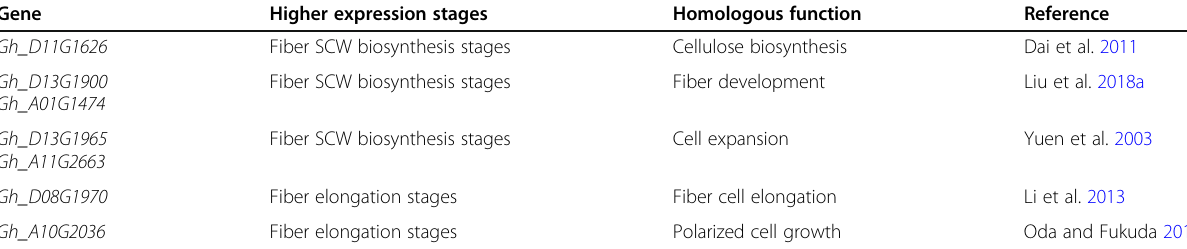
Table 4 The functional information of the key candidate gene homologous